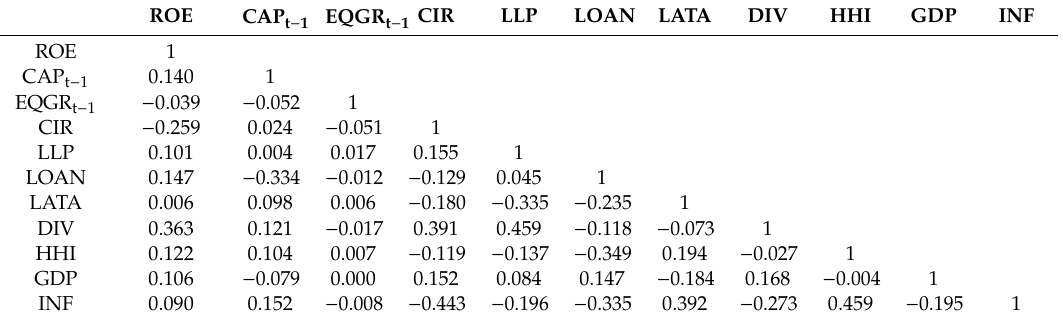
Table 3. Correlation matrix of variables used.